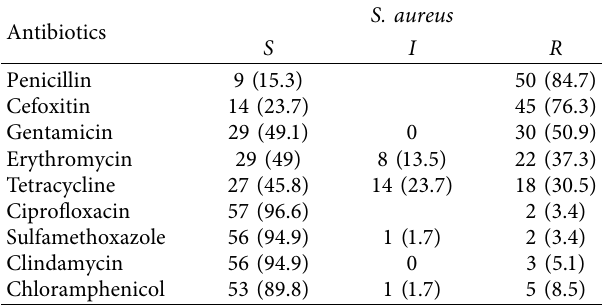
Table 5: Patterns of antibacterial susceptibility of bacterial isolates from raw cow milk in the study